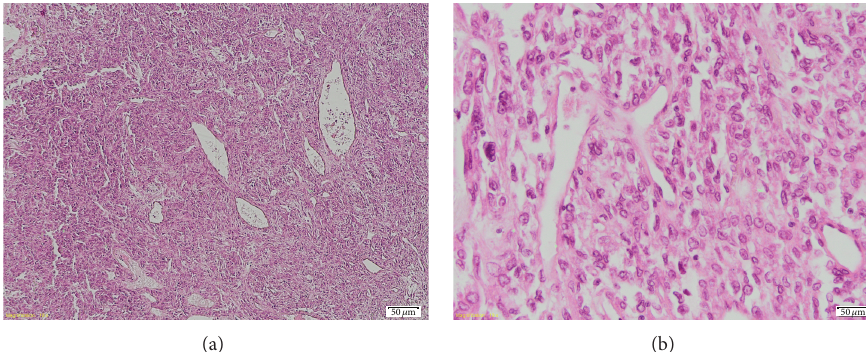
Figure 3: (a) Areas with heightened cellularity. The cells range from round/ovoid to slightly spindle; they are arranged randomly or in short ill-definedfascicles.(b)Athighermagnificationthetumorcellshaveindistinctcytoplasmandovalnuclei,usuallywithinconspicuousnucleoli.